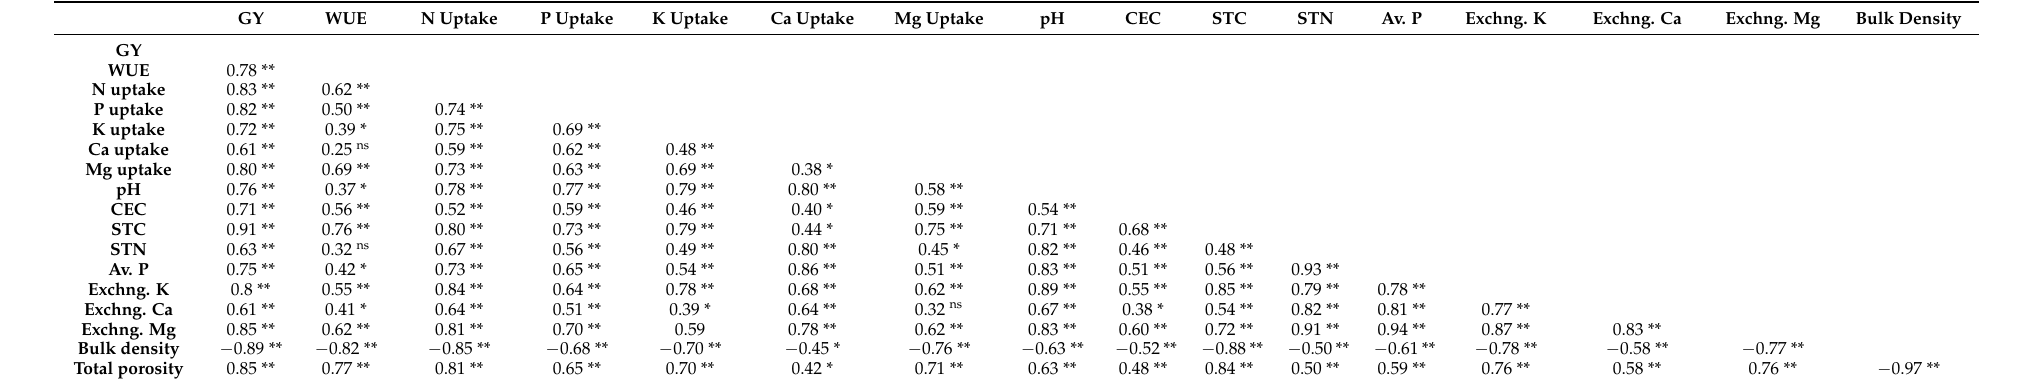
Table 7. Correlation coefficients between grain yield, water use efficiency, nutrient uptake and physicochemical properties of